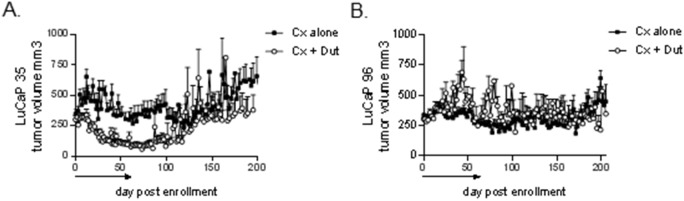
Tumor growth and androgen levels in prostate cancer xenografts treated with castration and dutasteride.Mean tumor volumes in mice bearing LuCaP35 (A) and LuCaP96 (B) xenografts. Intact male SCID mice were subcutaneously implanted with 30 mm3 pieces of the indicated xenograft. When tumors reached ∼300mm3, mice were castrated and randomly enrolled into cohorts treated with either vehicle (Cx) or dutasteride (Cx+Dut) for 8 weeks (denoted by black line above x-axis). Mean tumor volumes are depicted for each treatment group at the indicated days post enrollment (Cx, black squares; Cx+Dut, white circles).